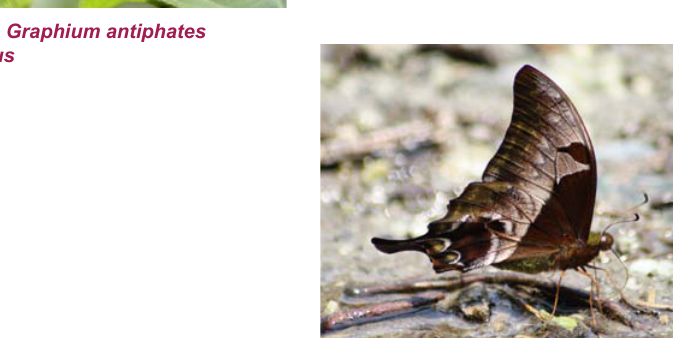
Image 5. Graphium agetes agetes